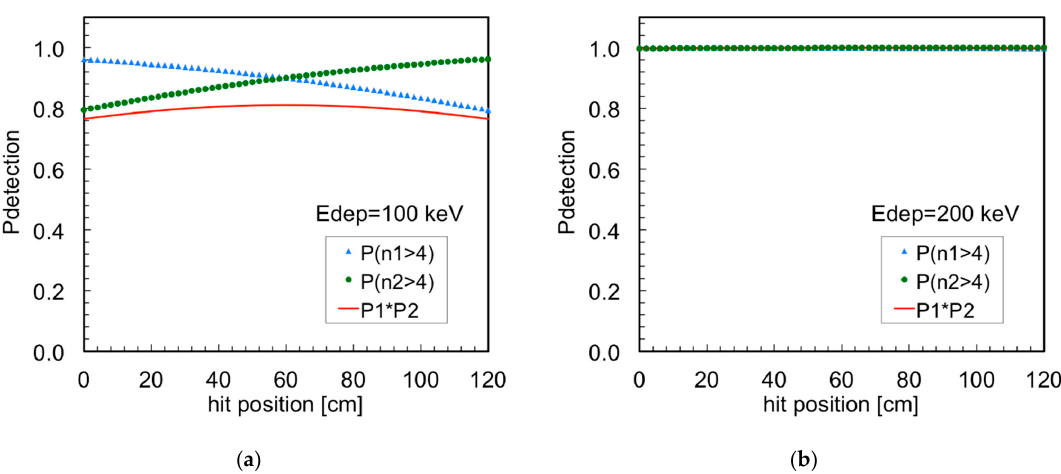
( b ) Figure 7. Detection efficiency of a gamma-ray as a function of the impact position on a 300 cm long fiber, calculated as the product of the probabilities of getting at least four photons detected on each SiPM. ( a ) When the gamma-ray deposits 100 keV . ( b ) When the gamma-ray deposits 200 keV. We opted for the 80 cm length, even in light of the height of the standard 120 and 210 L radwaste drums (76 and 88 cm). The scintillating fiber was allocated inside a 2 cm di- ameter and 1 mm thick aluminum pipe, and held in place by two cylindrical holders de- signed to host a circular PCB with the SiPM and its support circuitry. The holder has a central hole to allow for fiber-to-SiPM alignment and optical coupling by means of a tiny grease drop, and two side grooves to allow for the passage of cables (for this phase we chose the grease for reversibility, an optical glue will be the final solution). Two light-tight rubber caps complete the setup, with three cables coming out of one single side for the common voltage bias and the two output signals. A sketch and three pictures of the SciFi detector components are shown in Figure 8. We remark that the attenuation of gamma-